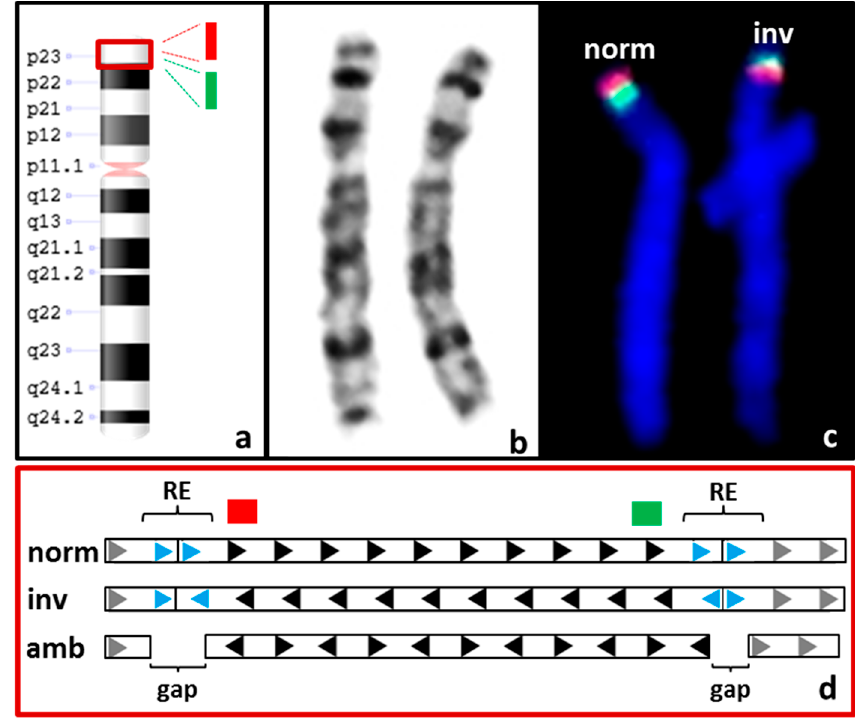
Figure 2. Inversion inv(8p23.1). The polymorphic inversion inv(8p23.1) of case S04 ( a ) is too small to be visible by karyotyping with GTG banding ( b ). Hence, it was initially detected by FISH analysis ( c ) using orange and green fluorescent probes that bind specifically to the inverted region (see orange and green fluorescent signals, blue: DAPI staining, the binding sites of the probes are indicated in ( a , d ) as green and orange blocks). Chromosome 8 carrying the inversion is depicted on the right (inv), with its green fluorescence signal above the orange signal, compared to normal chromosome 8 (norm) on the left side. ( d ) The repetitive elements (REs, represented by blue arrows) flank the segment that is proposed to be affected by the inversion (represented by black arrows). Gray arrows represent the surrounding sequences on chromosome 8p. When no inversion is present (norm), all arrows of the graphic representation are rightward oriented. When the inversion is present (inv), the arrows of the inverted segment are leftward oriented. The maps generated by OGM for case S04 did not span either RE (amb), leaving gaps and hence providing no frame of reference for the orientation of the segment between the REs. This creates ambiguity, where the inversion can be neither confirmed nor ruled out (represented by arrows with alternating orientation). By default, the Saphyr OGM system assumes the segment to be oriented correctly.